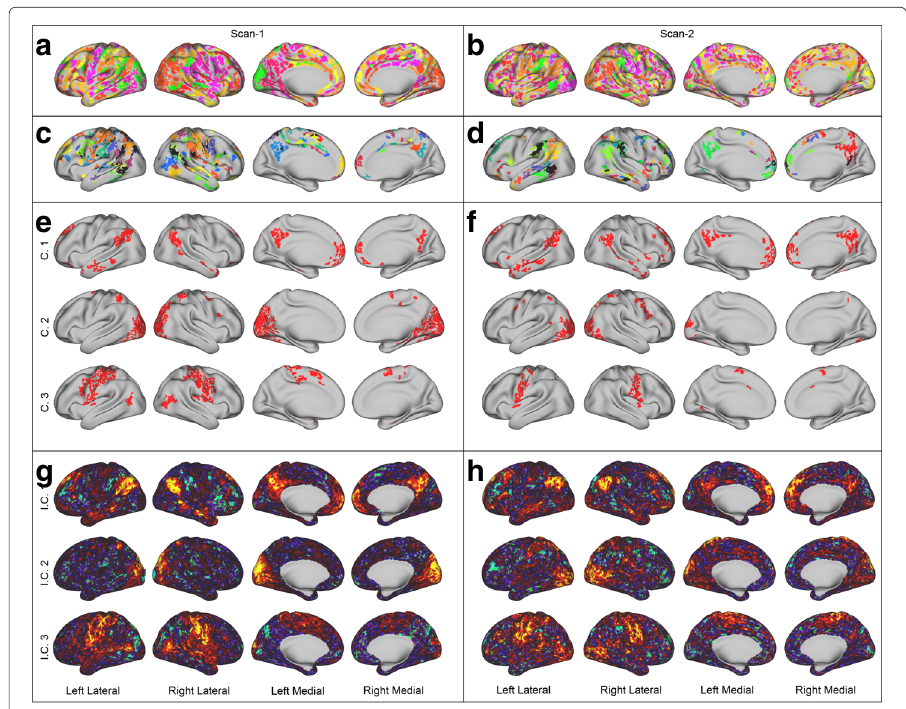
Fig. 6 Results for scan-1 (left panel) and scan-2 (right panel). ( a , b ) The identified domains, each domain is assigned a color randomly, overlaps are shown in green. ( c , d ) The domains of the backbone network, each domain is assigned a color randomly, overlaps are shown in black. ( e , f ) Three domain-level network communities for each scan. The first corresponds to the default-mode network, the second to the occipital network, and the third to the motor/somatosensory network. ( g , h ) Three independent components (corresponding to the domain level communities in ( e , f )) as identified by MELODIC